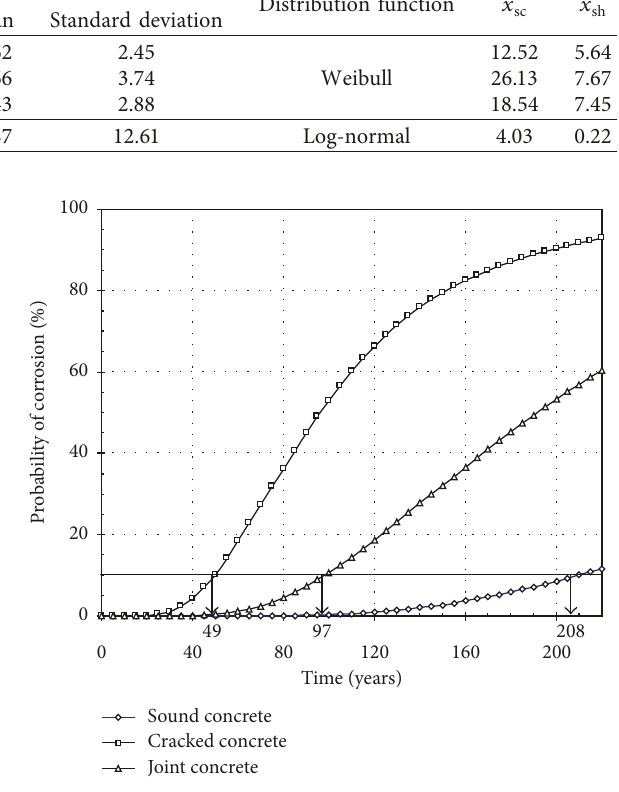
Figure 10: Probability of corrosion initiation for RC columns over